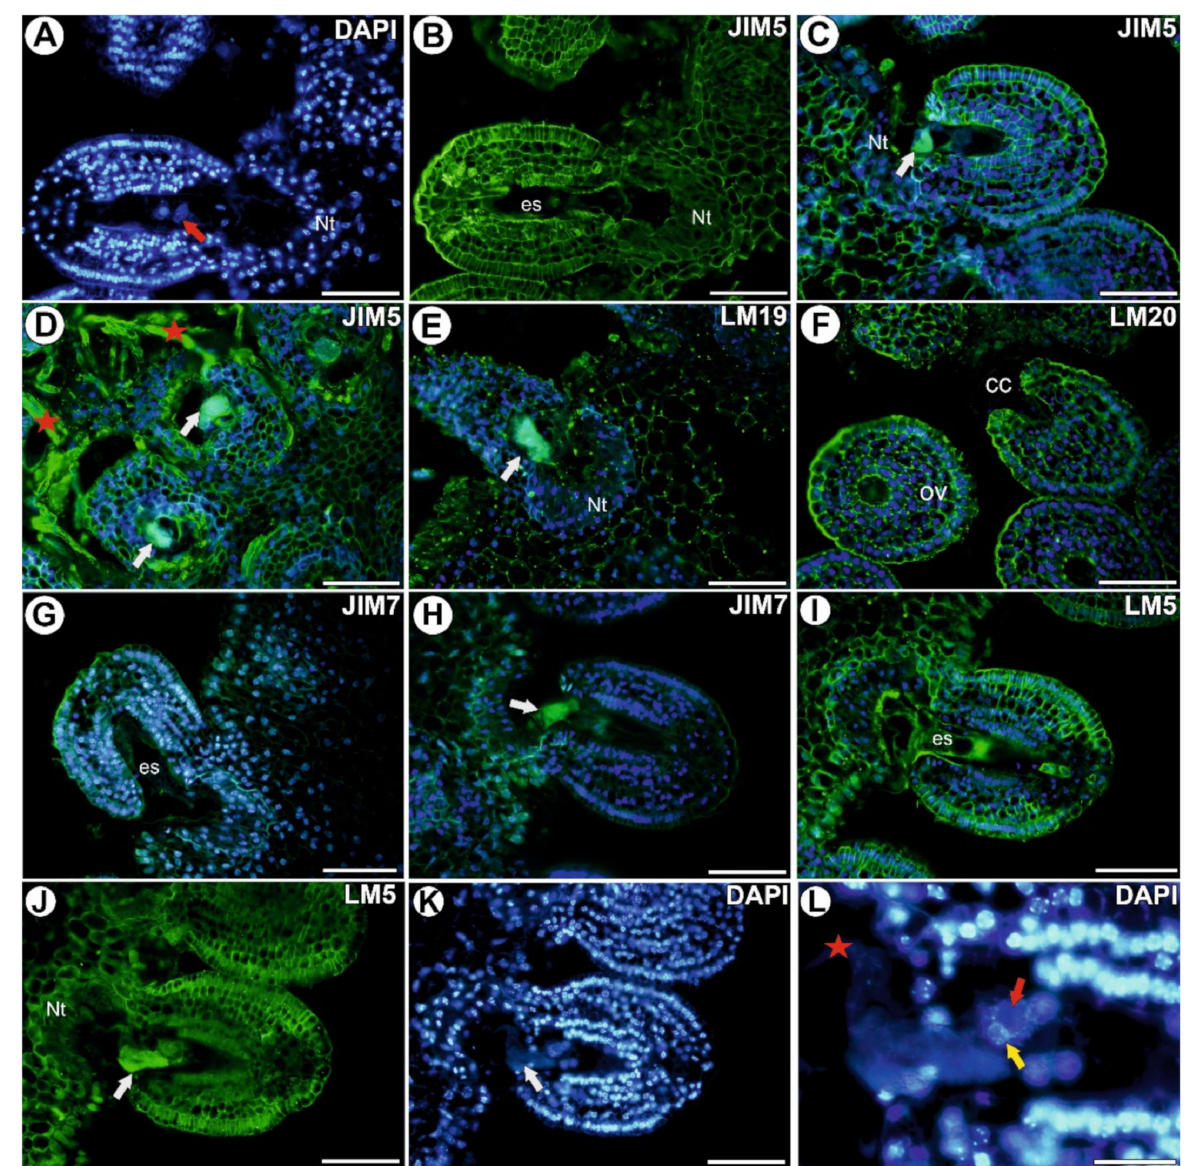
Figure 2. Homogalacturonan detected in an ovule of Utricularia nelumbifolia after pollination and after fertilization (Antibodies–green fluorescence). ( A , B ) Pectic epitope (labeled with JIM5) detected after pollination but before fertilization; mature embryo sac (es), egg cell (red arrow), placental nutritive tissue (Nt), bars 50 µ m. ( C , D ) Pectic epitope (labeled with JIM5) detected after fertilization; synergid after it had been penetrated by the pollen tube (white arrow), pollen tube (star), placental nutritive tissue (Nt), bars 50 µ m. ( E ) Pectic epitope (labeled with LM19) detected after fertilization; synergid after it had been penetrated by the pollen tube (white arrow), placental nutritive tissue (Nt), bar 50 µ m. ( F ) Pectic epitope (labeled with LM20) after pollination but before fertilization; ovule (ov), hypertrophied part of the central cell (cc), bars 50 µ m. ( G ) Pectic epitope (labeled with JIM7) after pollination but before fertilization; mature embryo sac (es), bar 50 µ m. ( H ) Pectic epitope (labeled with JIM7) after fertilization; synergid after it had been penetrated by the pollen tube (white arrow), bar 50 µ m. ( I )) Pectic epitope (labeled with LM5) detected after pollination but before fertilization; mature embryo sac (es), bar 50 µ m. ( J , K ) Pectic epitope (labeled with LM5) detected during fertilization; synergid after it had been penetrated by the pollen tube (white arrow), placental nutritive tissue (Nt), bar 50 µ m. ( L ) Fertilization of the egg cell; note the nucleus of the sperm cell (yellow arrow) and egg cell nucleus (red arrow), pollen tube (red star), bar 20 µ